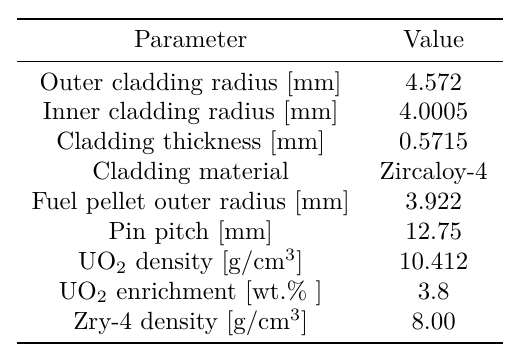
Table 1. WWER-1000 fuel pin parameters used in the simulation.